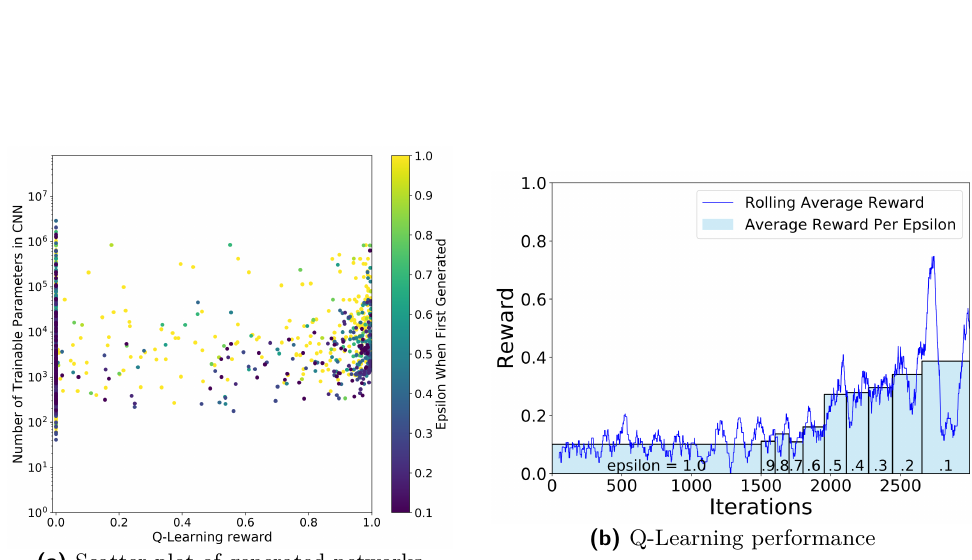
Figure 18: An overview of both the number of trainable parameters, reward, ε , and Q-Learning performance when R = GE 0